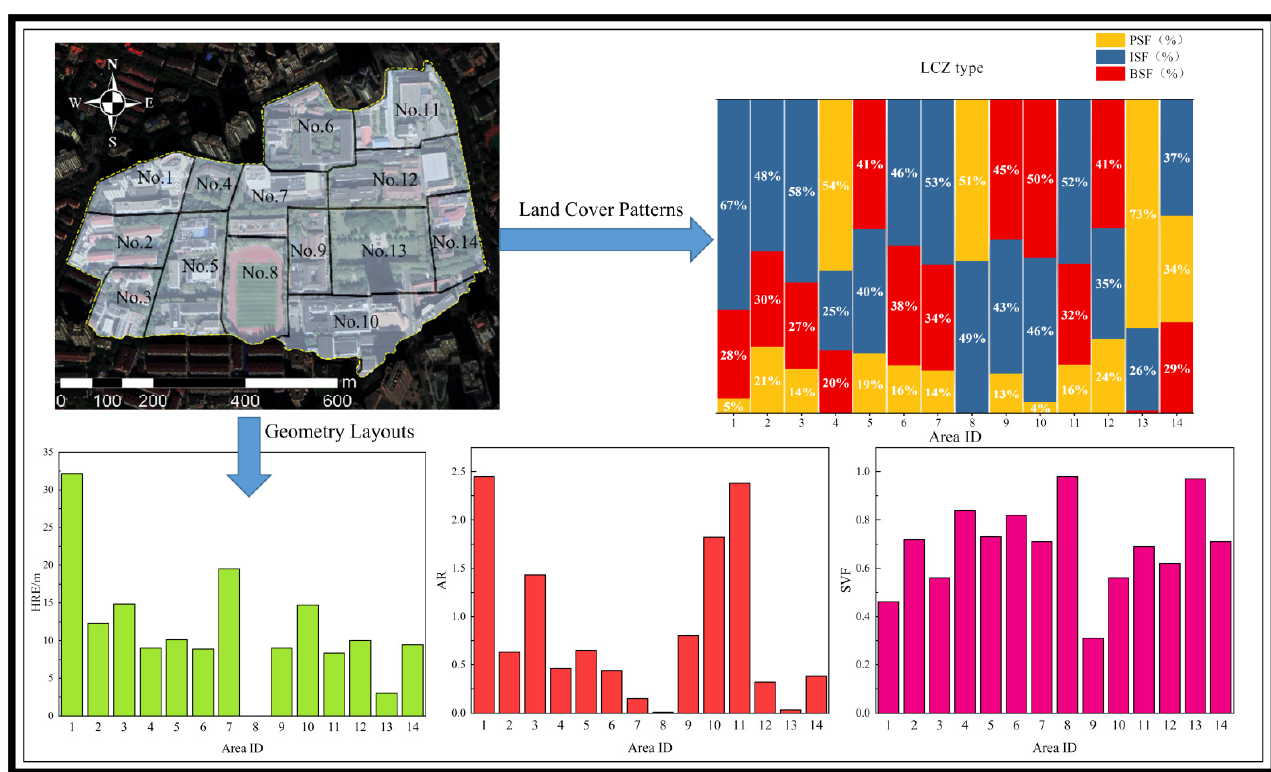
Figure 2. Local zone divisions within the campus in Shanghai and the distribution chart of spatial morphology characteristic parameters in each local zone.